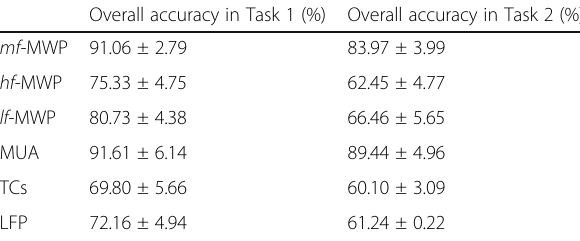
Table 3 Overall accuracy of the decoders when using different neural features as input Overall accuracy in Task 1 (%) Overall accuracy in Task 2